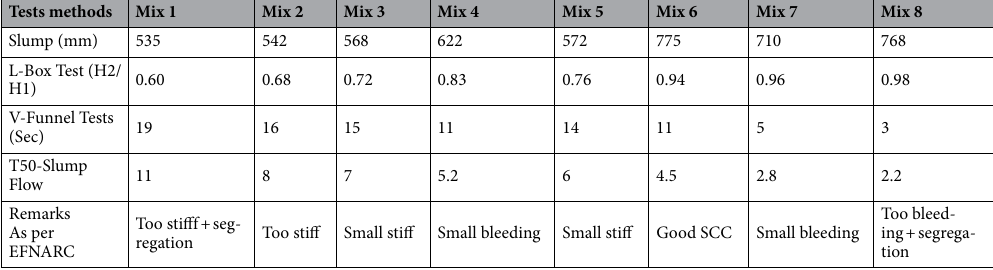
Table 8. First stage results.